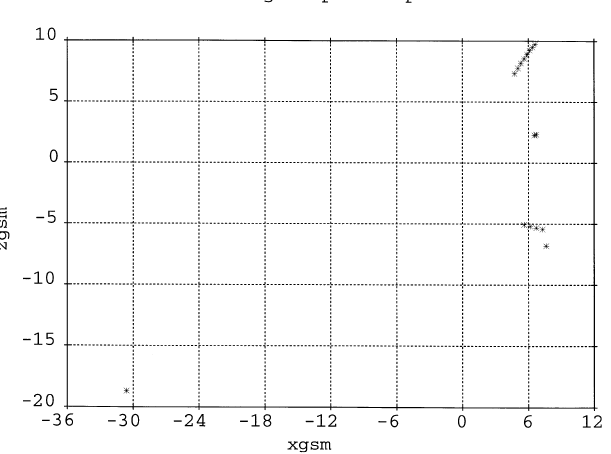
Fig. 5. Same as Fig. 4. The data set for Kp = 5 has been filtered in the same conditions with the Sibeck magnetopause model adapted to Kp = 5. The lack of data points is even more important